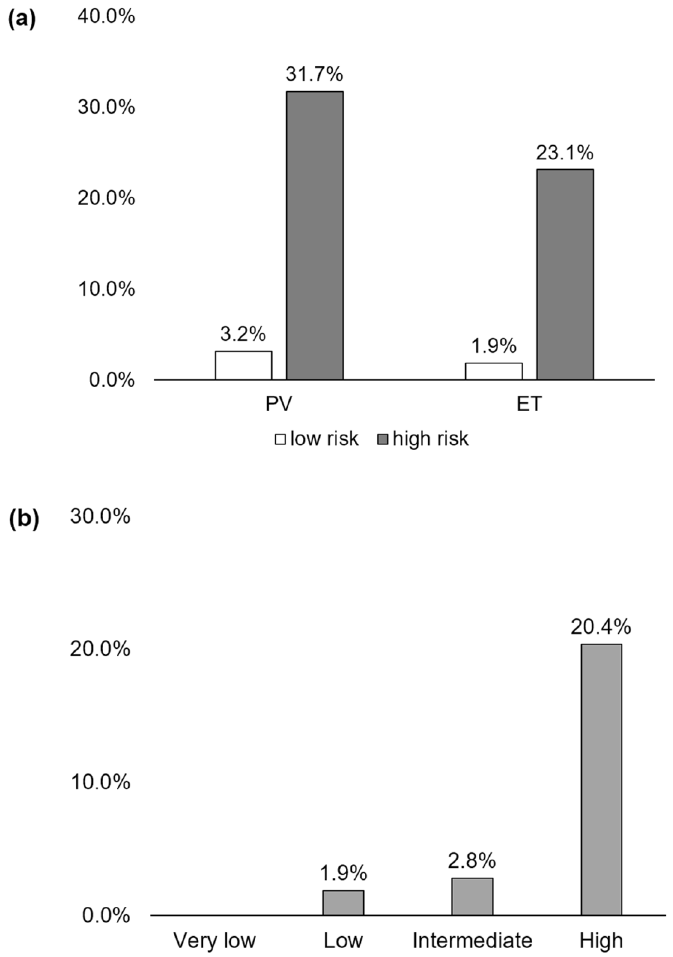
Figure 2. Thromboembolic events according to risk stratification. ( a ) Polycythemia vera and essential thrombocythemia (ET) patients according to conventional risk stratification according to age and history of thrombosis. ( b ) ET patients IPSET-thrombosis risk